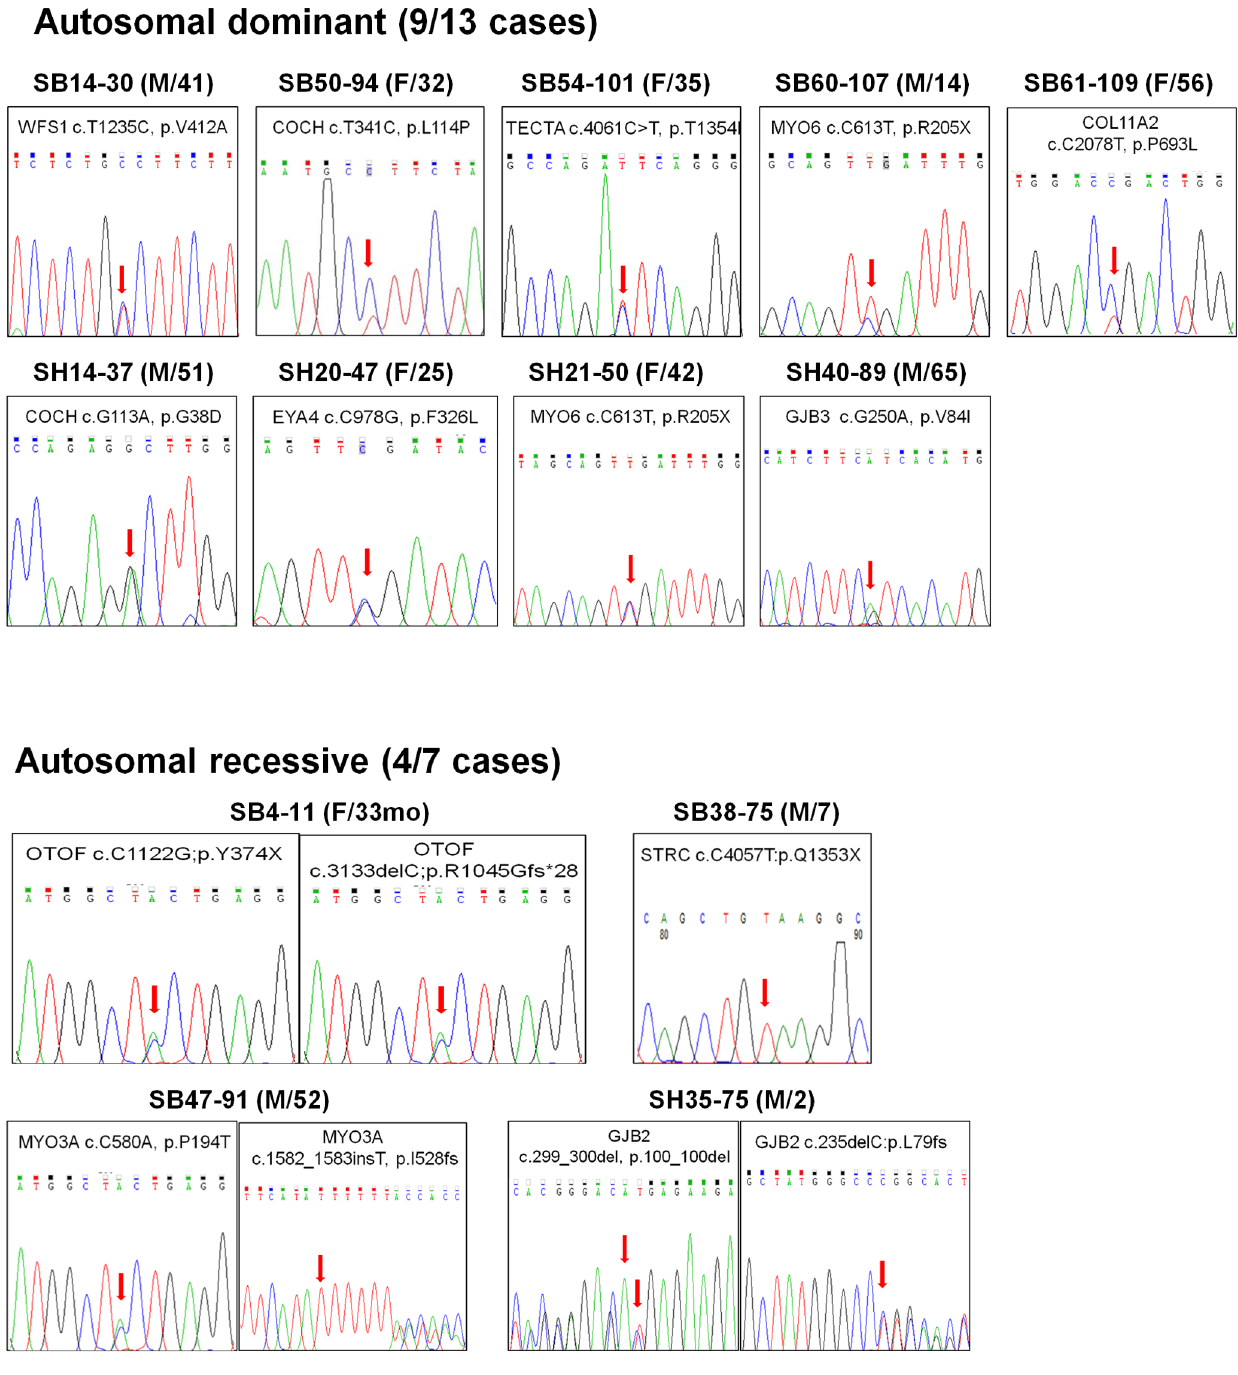
Figure 2. Validation of candidate mutations by PCR-Sanger sequencing. Candidate mutations in 9 autosomal dominant and 4 autosomal recessive NSHL families were shown in chromatogram of Sanger sequencing.